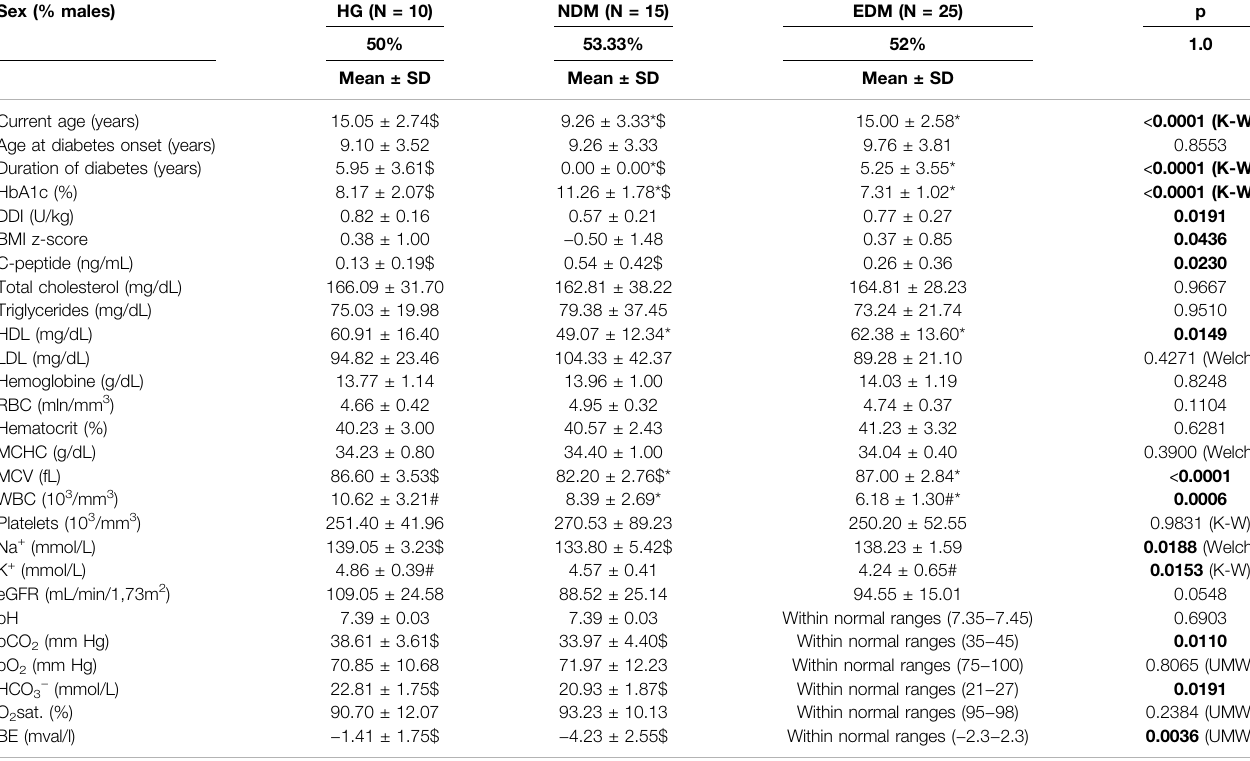
TABLE 1 | Study groups ’ characteristics selected for metabolomics fi ngerprinting of the past hypoglycemia episode. Sex (%